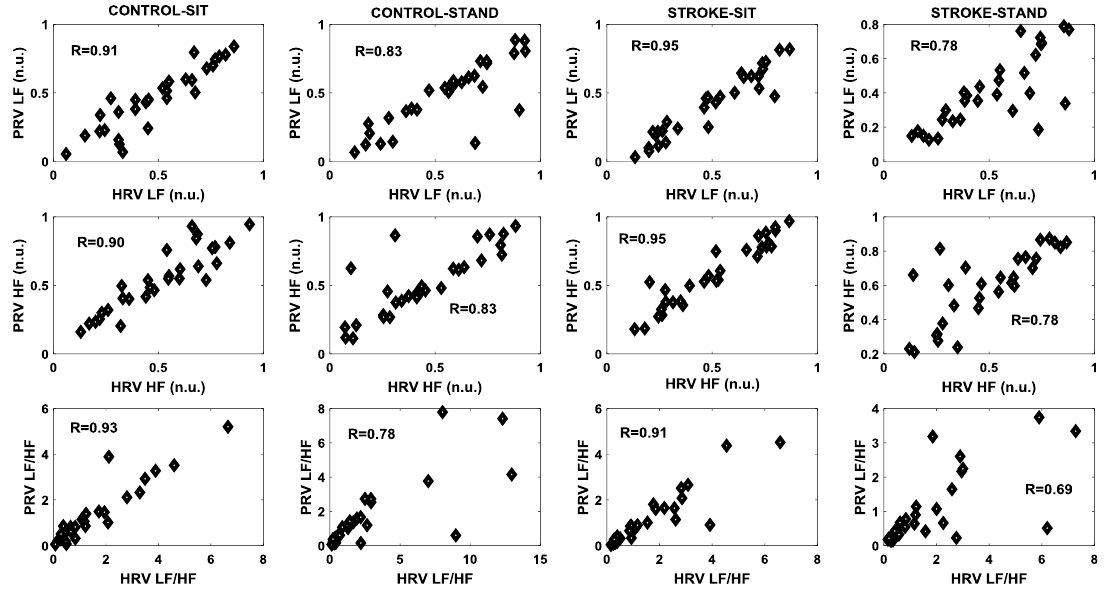
Figure 4. The degree of agreement, determined by computing the Pearson correlation coefficient, between HRV and PRV for different frequency domain features for the two groups (control/stroke) and conditions (sit/stand).